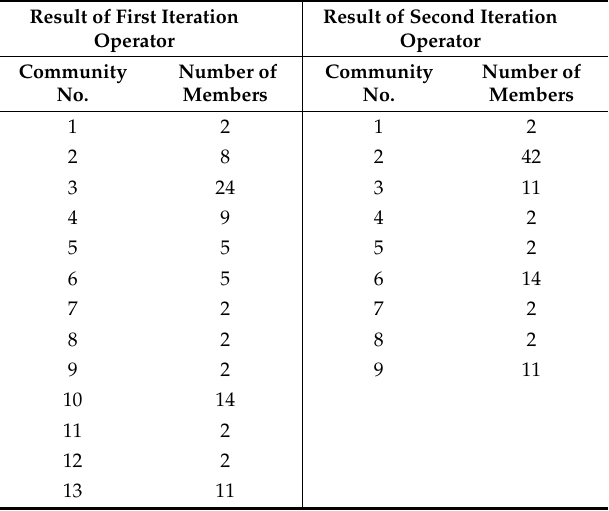
Table 4. Result of discovering community structure for 88 samples via the Louvain algorithm. Result of First Iteration Operator